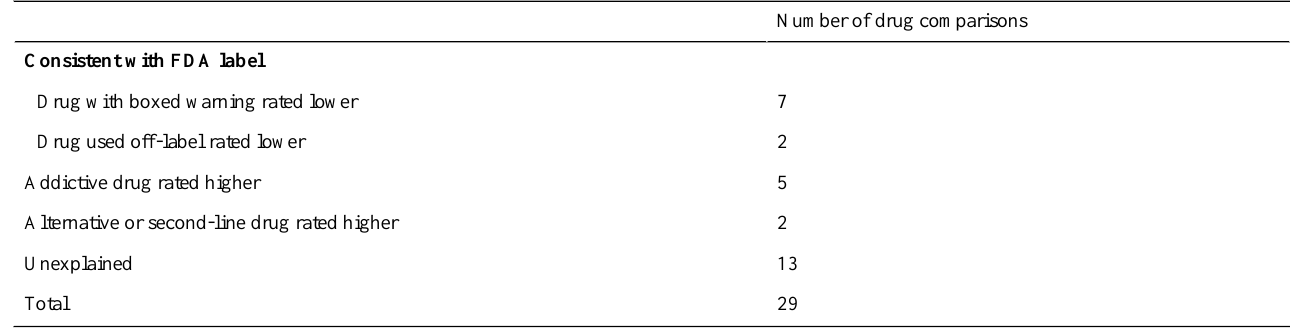
Table 1. Summary of observations for drug comparisons where Web-based ratings disagreed with